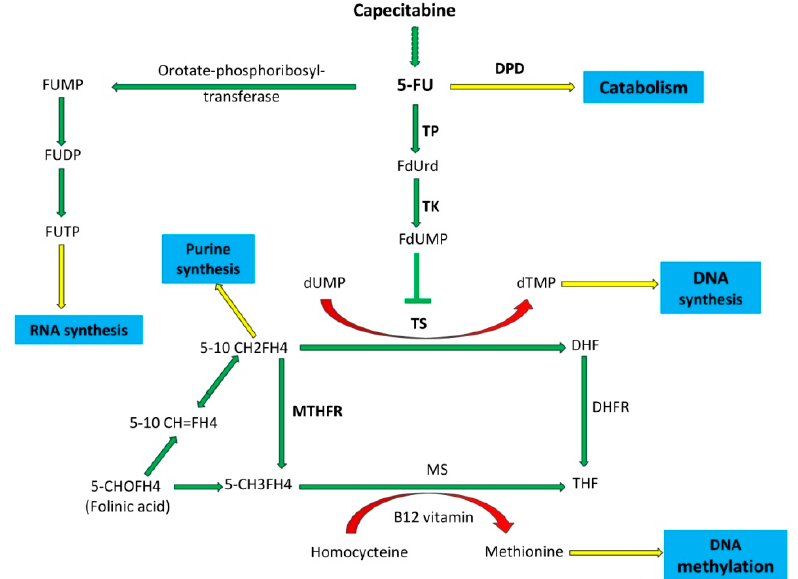
Figure 1. Metabolism pathway of capecitabine and 5-fluorouracil (5-FU). Abbreviations: 5-fluoro uracil (5-FU), Thymidine phosphorylase (TP), 5-fluorodeoxyuridine (FdUrd), thymidine kinase (TK), 5-10 methylene-tetrahydrofolate (5-10 CH2FH4), dihydrofolate (DHF), 5-methyltetrahydrofolate (5-CH3FH4), methionine synthase (MS), tetrahydrofolate (THF), dihydrofolate reductase (DHFR), 5-formyltetrahydrofolate (folinic-acid) (5-CHOFH4), and 5-10 methenyltetrahydrofolate (5-10 CH=FH4).